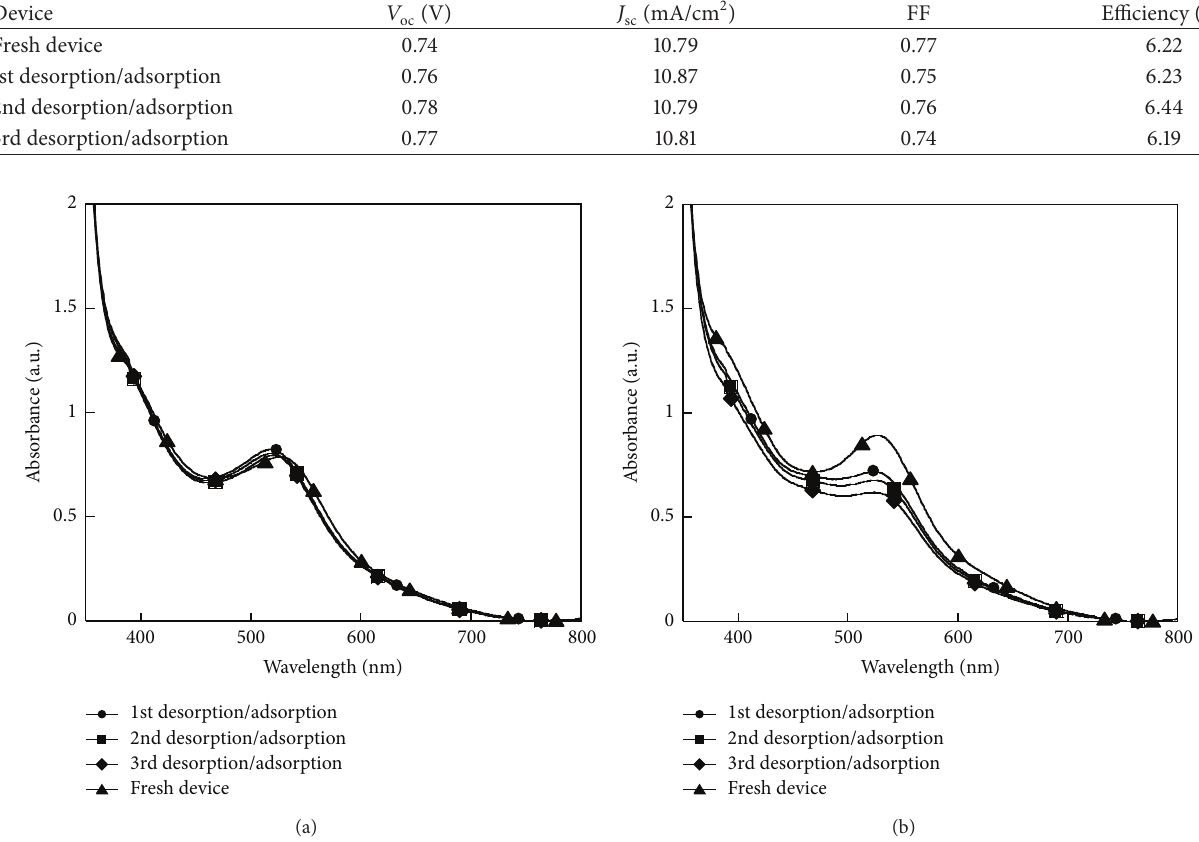
Figure 2: UV-Vis absorption spectra of dyed TiO 2 following readsorption of N719 dye using (a) 5 × 10 −3 M NaOH and (b) 10 −5 M CH 3 COOH as desorption agents under multiple adsorption/desorption